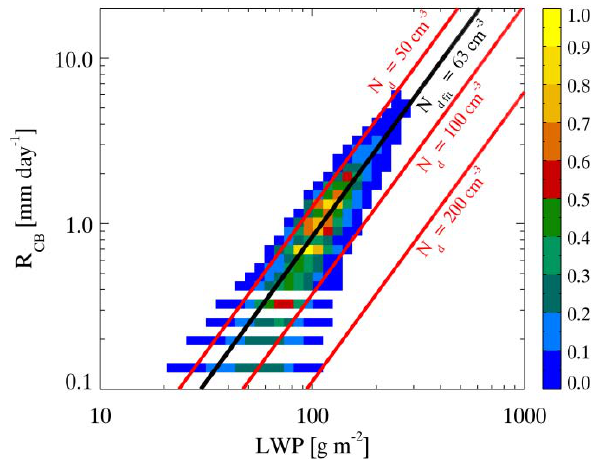
Fig. 9. Cloud droplet number concentration measured along the 20 ◦ S latitude line by the C-130 and BAe-146 research aircraft. The bars span the interquartile range and the median is shown by filled symbols.